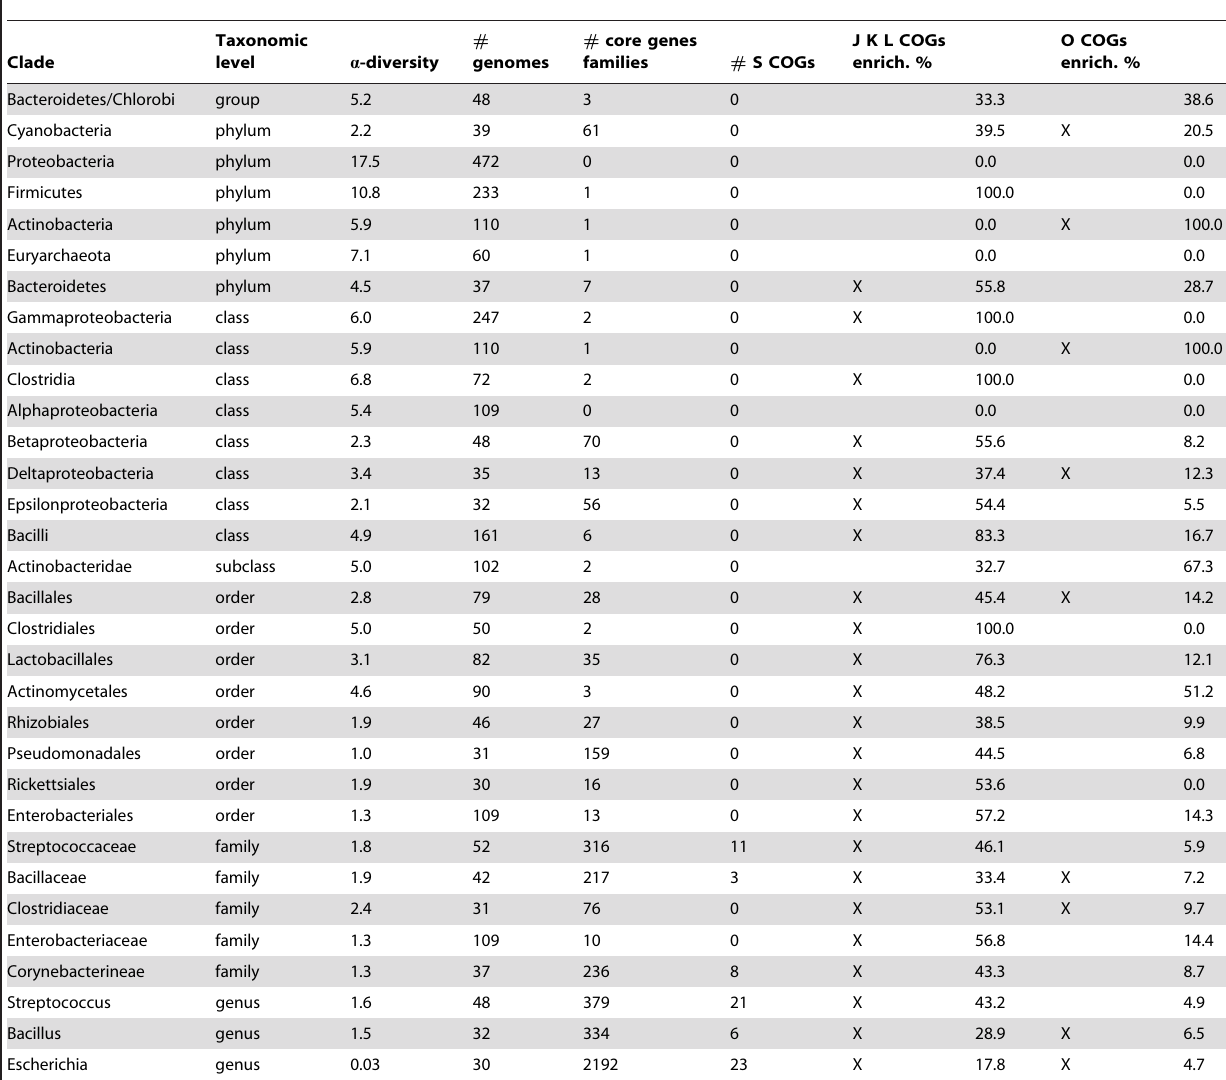
Table 1. Overview of core gene set size and function for clades including at least 30